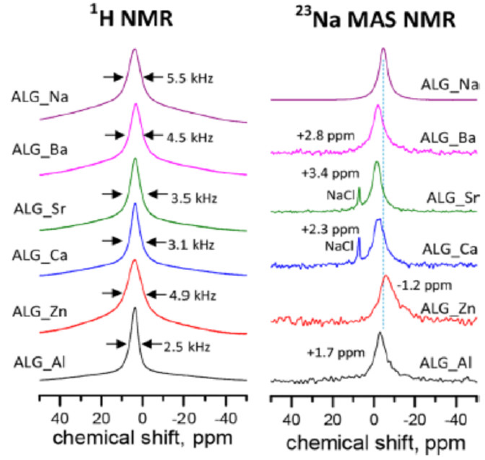
Figure 9. 1 H NMR and 23 Na MAS NMR spectra of mono- (Na + ) and multivalent ions alginate gels. Reprinted with permission from [216] (Available online: ttps://pubs.acs.org/doi/full/10.1021/acs.biomac.7b00627. Accessed on 14 November 2022. Further permission related to the material excerpted should be directed to the ACS).